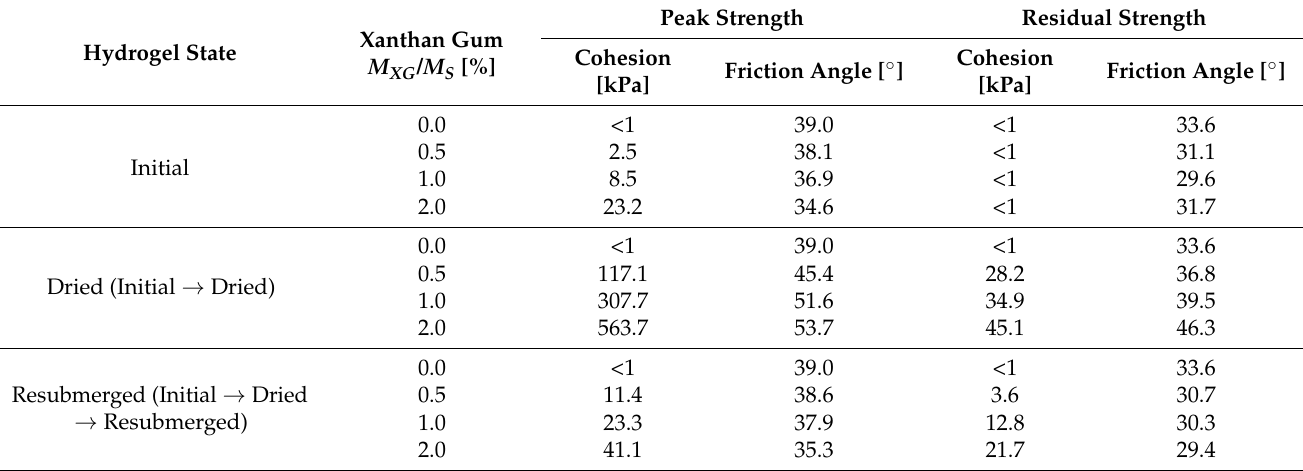
Table 4. Mohr–Coulomb failure parameters determined from linear regression (soil–soil shearing) .